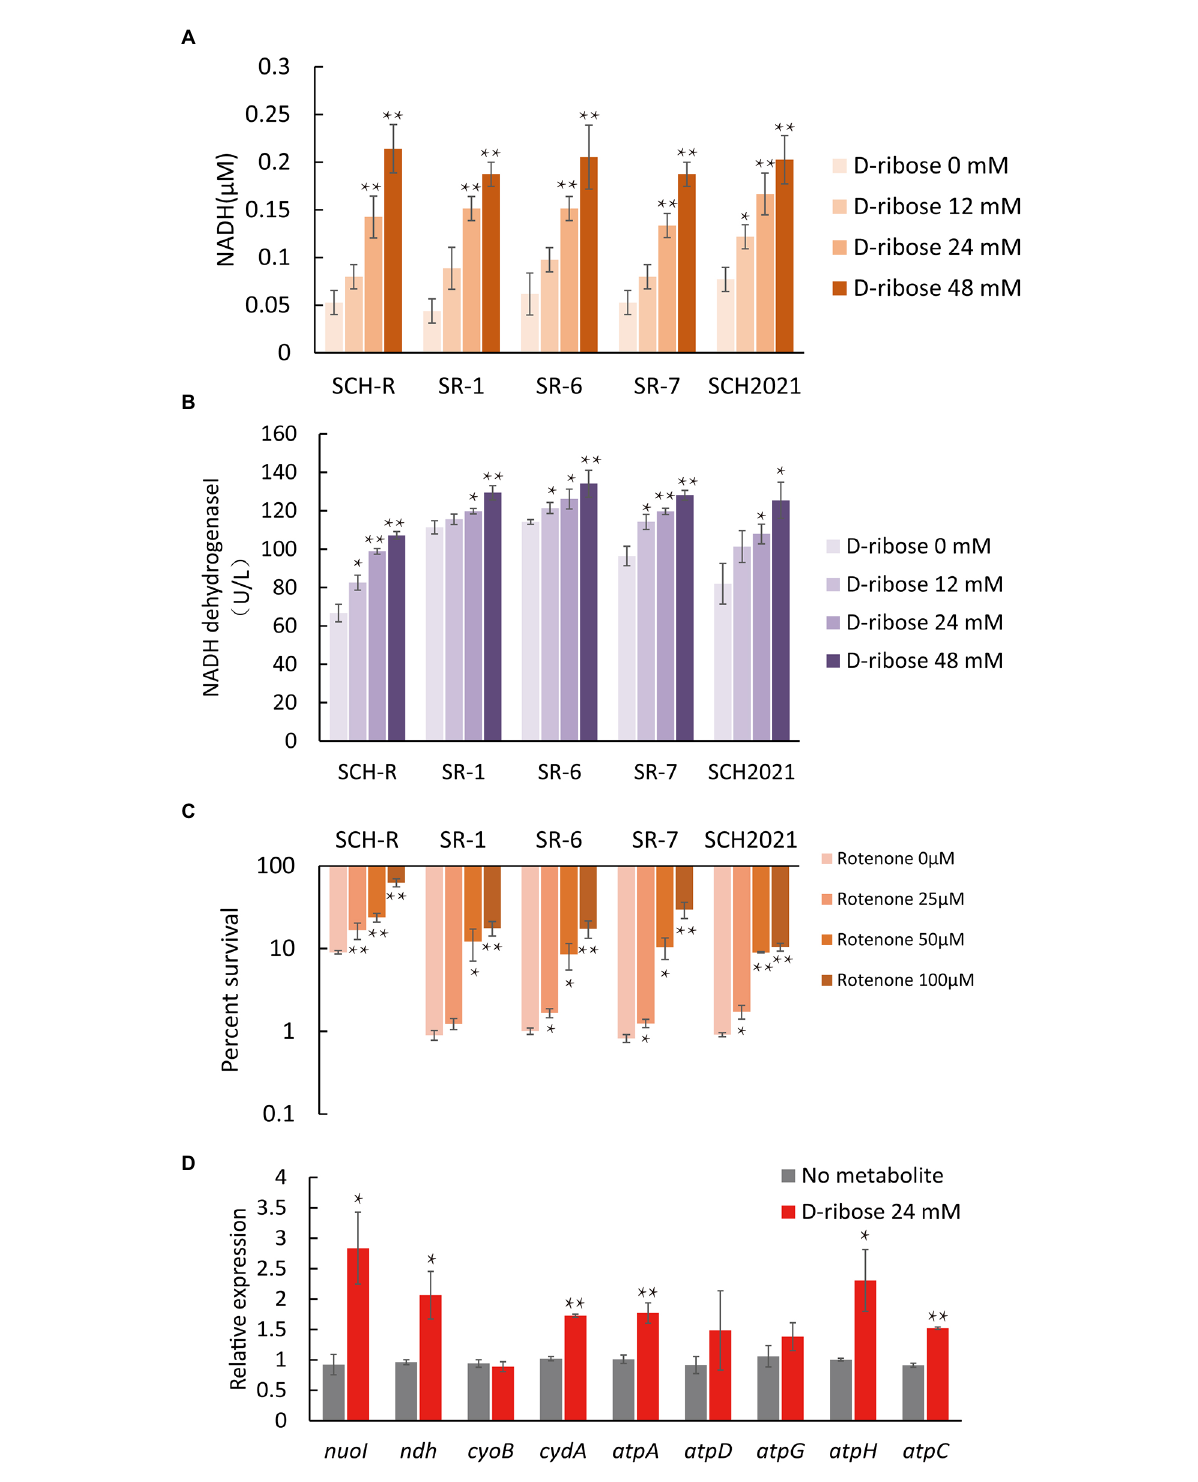
FIGURE 6 Effect of exogenous D-ribose on the electron transport chain. (A) The intracellular NADH concentration of SCH-R and clinical isolates by D-ribose dose. (B) Activity of NADH dehydrogenase 1 in SCH-R and clinical isolates by D-ribose dose. (C) Percent survival of SCH-R and clinical isolates by rotenone dose and 1 MIC gentamicin plus 24 mM D-ribose. (D) QRT-PCR of key electron transport chain genes in the presence 24 mM D-ribose. nuoI , NADH dehydrogenase I chain I; ndh , NADH:quinone reductase; cyoB , cytochrome o ubiquinol oxidase subunit I; cydA , cytochrome BD2 subunit I; atpA , atpD , atpG , atpH and atpC , membrane-bound ATP synthase, F1 sector, alpha-subunit, beta-subunit, gamma-subunit, delta- subunit, and epsilon-subunit. Results are displayed as the mean ± SEM and three biological repeats are carried out. Significant differences are identified ( *p < 0.05 and **p <